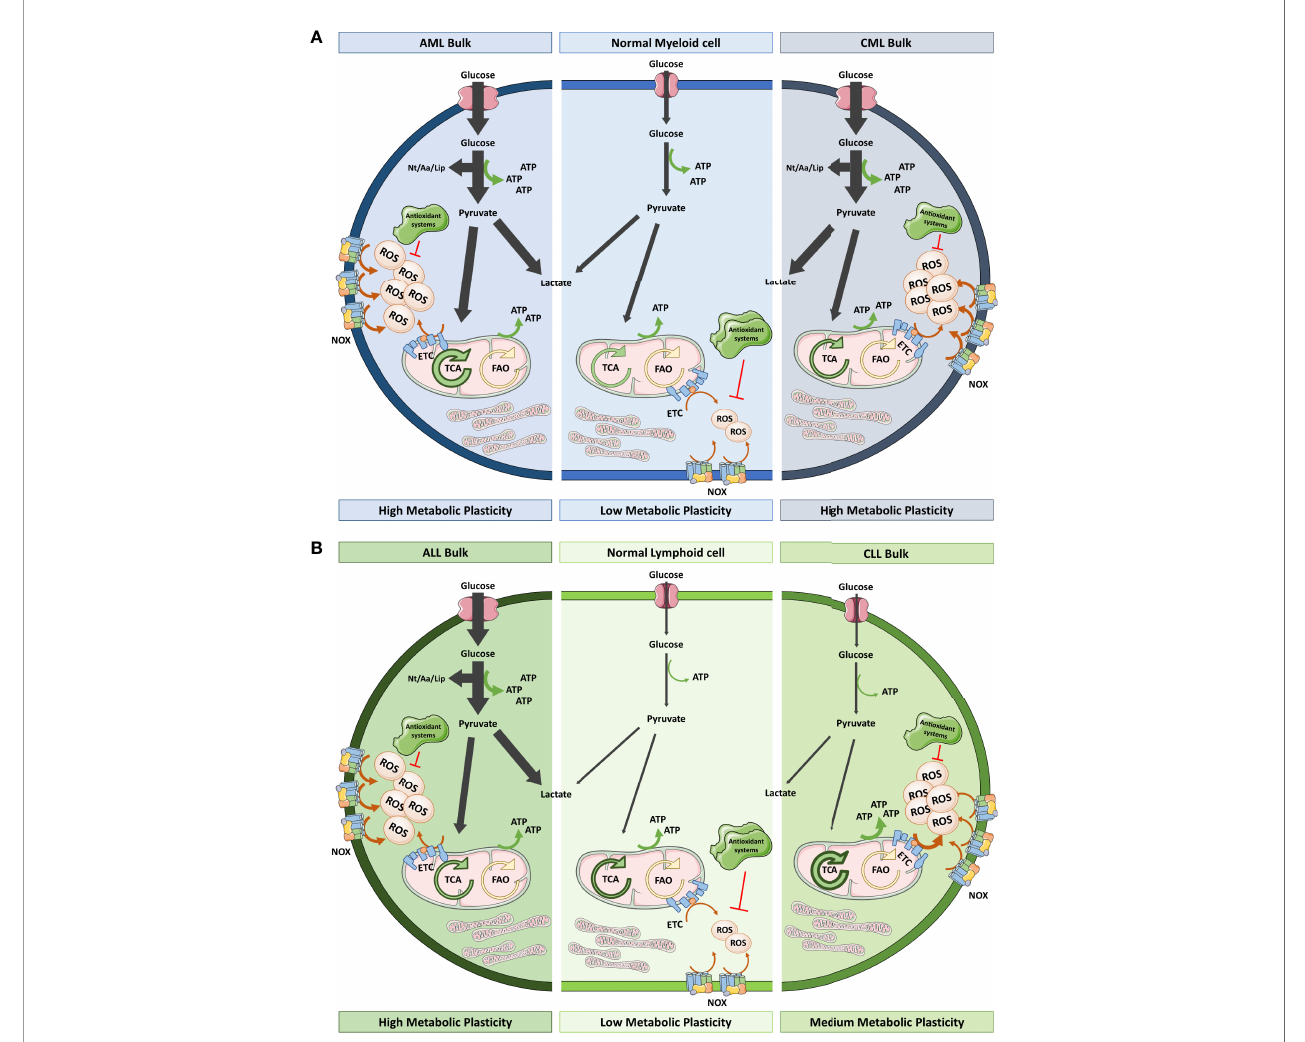
FIGURE 2 | Redox and metabolic status of myeloid and lymphoid cells versus their leukemic counterparts. (A) Healthy myeloid cells obtain ATP from glycolysis and OXPHOS in a balanced way. They produce moderate ROS levels that could be variable depending on the differentiation status. However, AML bulk cells overstimulate glycolysis and TCA driven OXPHOS (thick arrows) to satisfy their proliferation needs in terms of energy and building blocks (Nt, Aa and Lip). This exacerbated metabolism together with the elevated NOX levels means that these cells are exposed to high oxidative stress. On the other hand, CML bulk cells rely more on glycolysis as BCR-ABL conditioned the metabolism towards aerobic fermentation. CML bulk cells contain elevated ROS levels coming from NOX and mitochondrial metabolism. Both, AML and CML, have been described as having low levels of antioxidant systems. (B) Healthy lymphoid cells hardly use glycolysis for energy obtaining instead they have an active TCA that triggers OXPHOS. ALL bulk cells have increased glycolytic fl ux comparing to their healthy counterparts whereas CLL bulk cells display TCA driven OXPHOS dependency for energy production. ALL and CLL bulk cells show high ROS levels as a result of high NOX expression, low antioxidant systems and, in the case of CLL, hyperactivation of ETC. Leukemic cells, irrespective of the lineage of origin, show notorious metabolic plasticity which permits their adaptation to different cellular stimuli and metabolic sources. Aa, amino acids; AML, acute myeloid leukemia; ALL, acute lymphocytic leukemia; CLL, chronic lymphocytic leukemia; CML, chronic myeloid leukemia; ETC, electron transport chain; FAO, fatty acid oxidation; Lip, lipids; NOX, NADPH oxidase; Nt, nucleotides; OXPHOS, oxidative phosphorylation; TCA, tricarboxylic